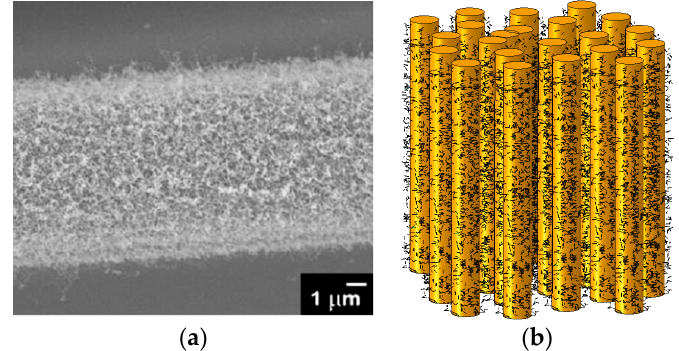
Figure 6. Micrograph of a carbon fiber with CNT reinforcements in fiber-matrix interface ( a ) and computational model of a composite with secondary CNT particles ( b ). (Reprinted from [65,69] with kind permission from Elsevier).